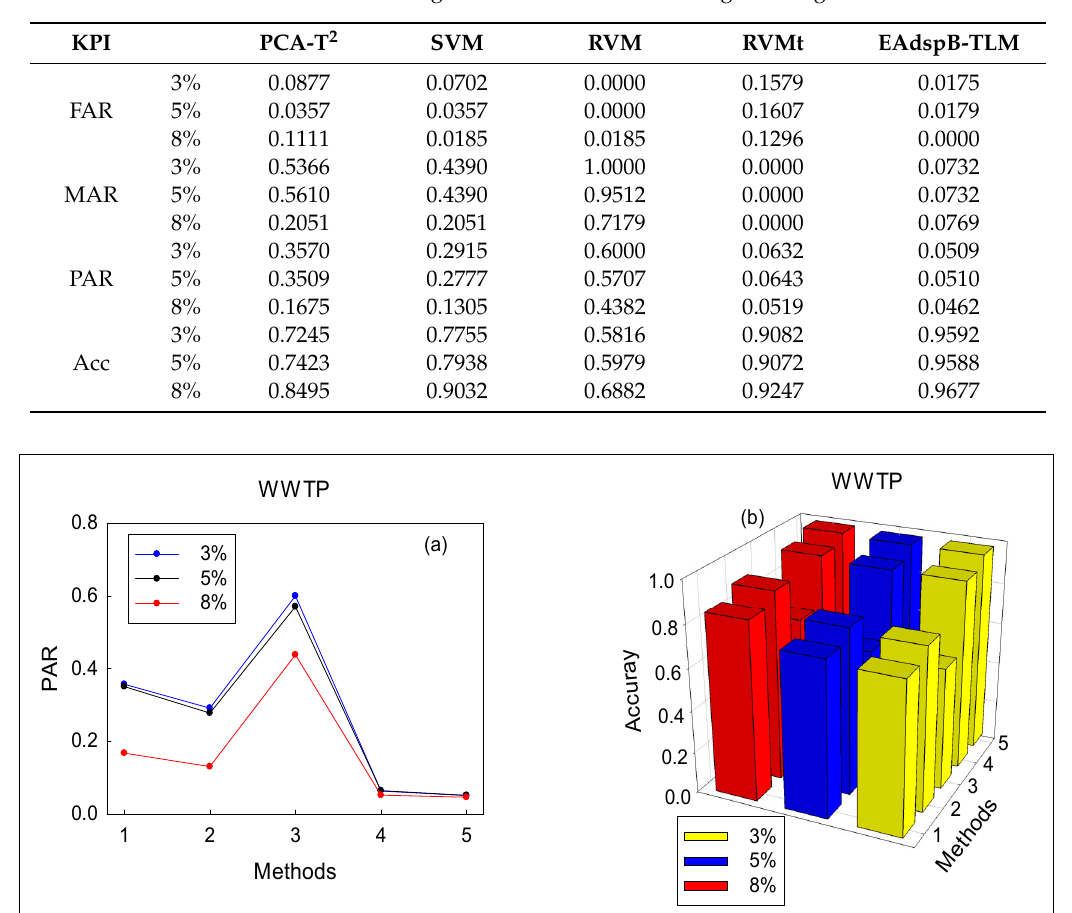
Figure 7. Average of comprehensive KPIs based on the proposed method and four other methods: ( a ) PAR; ( b ) accuracy.